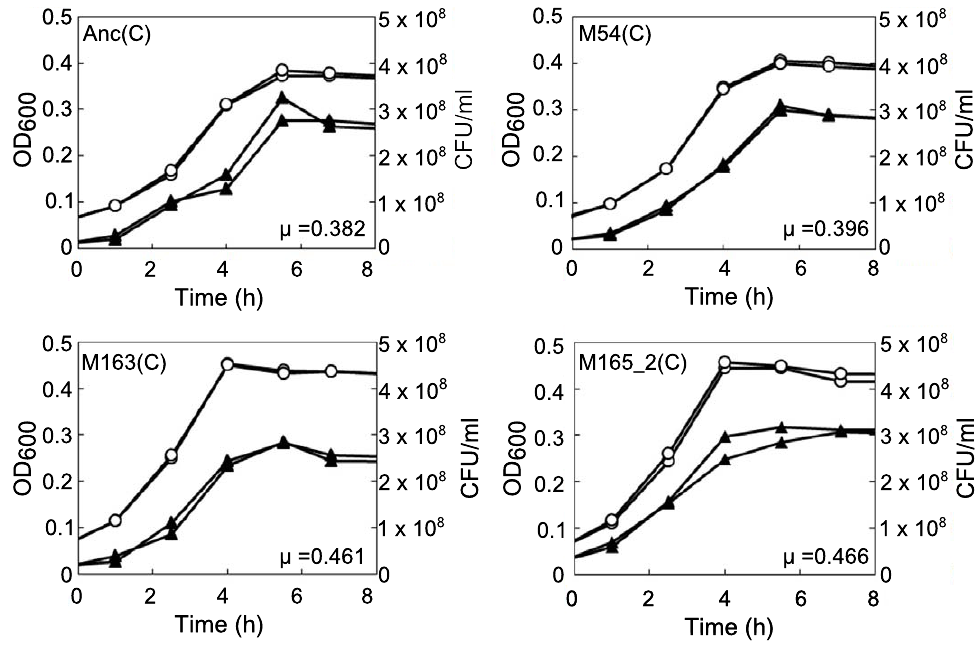
Figure 6. Growth curves of ancestral and evolved E.coli . The growth curves of Anc(C), M54(C), M163(C), and M165_2(C) without phage infection were plotted based on OD 600 and CFU/ml. Each experiment was conducted in duplicate. The open circles and closed triangles represent the OD 600 and CFU/ml, respectively. The specific growth rate ( m ) calculated from the semi-logarithmic plots based on OD 600 of Anc(C), M54(C), M163(C), and M165_2(C) were 0.382 h 2 1 (r 2 =0.998), 0.396 h 2 1 (r 2 =0.996), 0.461 h 2 1 (r 2 =0.998), and 0.466 h 2 1 (r 2 =0.996), respectively. The times to reach stationary phase based on OD 600 of Anc(C), M54(C), M163(C), and M165_2(C) were 4.60 and 4.57 h, 4.47 and 4.44 h, 3.86 and 3.83 h, and 3.88 and 3.82 h, respectively.